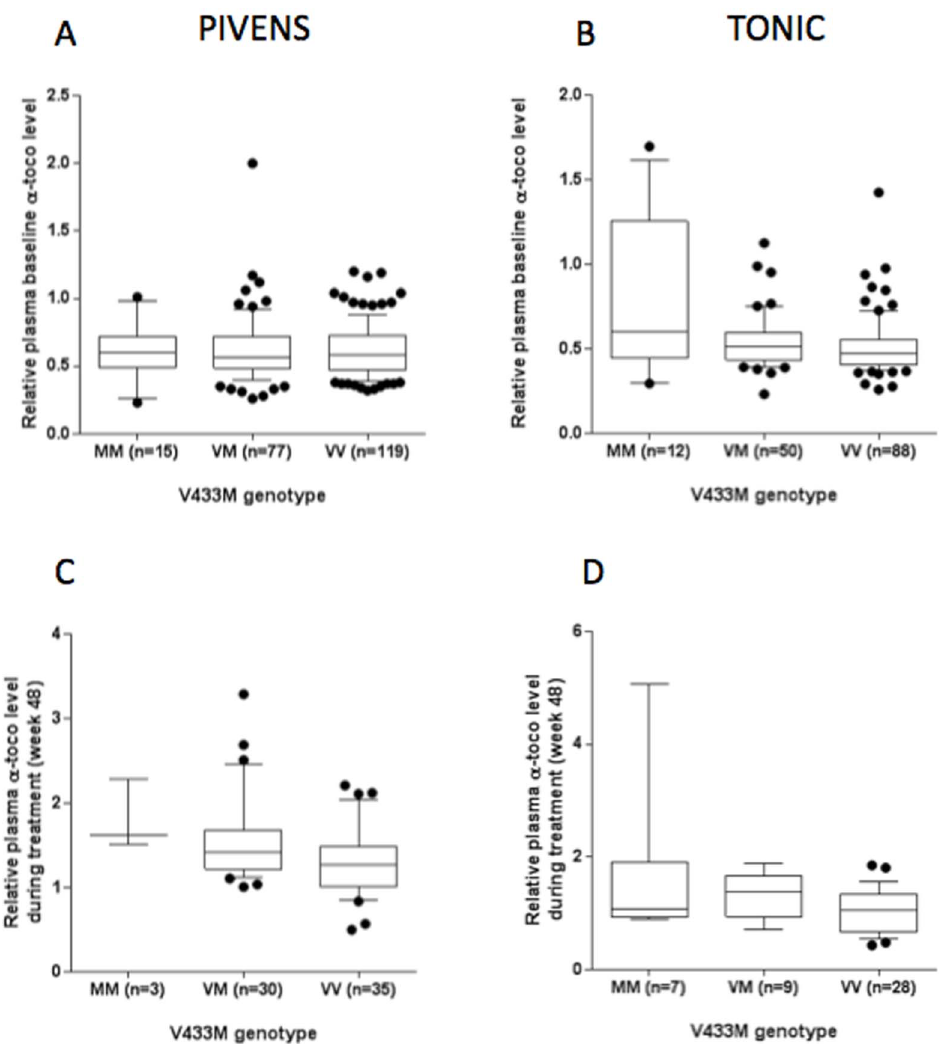
Figure 1. Association between CYP4F2 V433M polymorphism and a -tocopherol levels at baseline (entire cohort) and during the intervention phase (in Vit E treated participants) in PIVENS and TONIC trials. Data shown in Box (horizontal bar in the box indicates median) and whiskers plot (with 10–90 percentile). Panel A: Relationship between V433M genotype and baseline a tocopherol level in PIVENS (p=ns). Panel B: Relationship between V433M genotype and baseline a tocopherol level in TONIC (p=0.004). Panel C: Relationship between V433M genotype and week 48 a tocopherol level in PIVENS (p=0.004). Panel D: Relationship between V433M genotype and week 48 a tocopherol level in TONIC